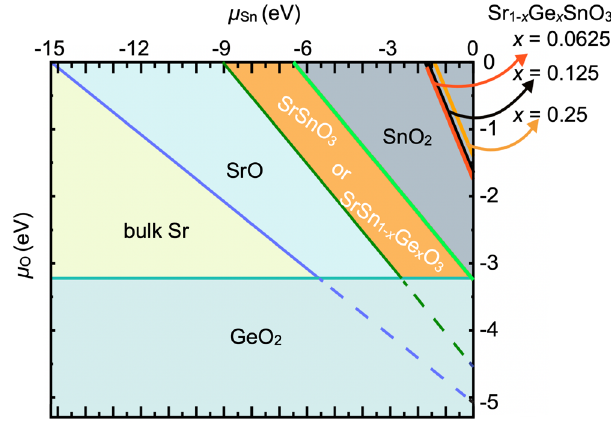
Fig. 6 Thermodynamic site preference of Ge in SrSnO 3 . Calculated region in the tin chemical potential ( μ Sn ) vs oxygen chemical potential ( μ O ) plane showing where B-site alloys have lower formation enthalpy than the A-site alloys. The lines in the upper right corner ( x = 0.0625, x = 0.125, and x = 0.25) separate the regions below which B-site alloys are preferred. This result indicates that for all allowed values of μ Sn and μ O for which SrSnO 3 is stable (orange region at the center), Ge will prefer to occupy the Sn site. The stability of SrSnO 3 is limited by the formation of SrO on the left (dark- green line, corresponding to) and the formation of SnO 2 on the right (light-